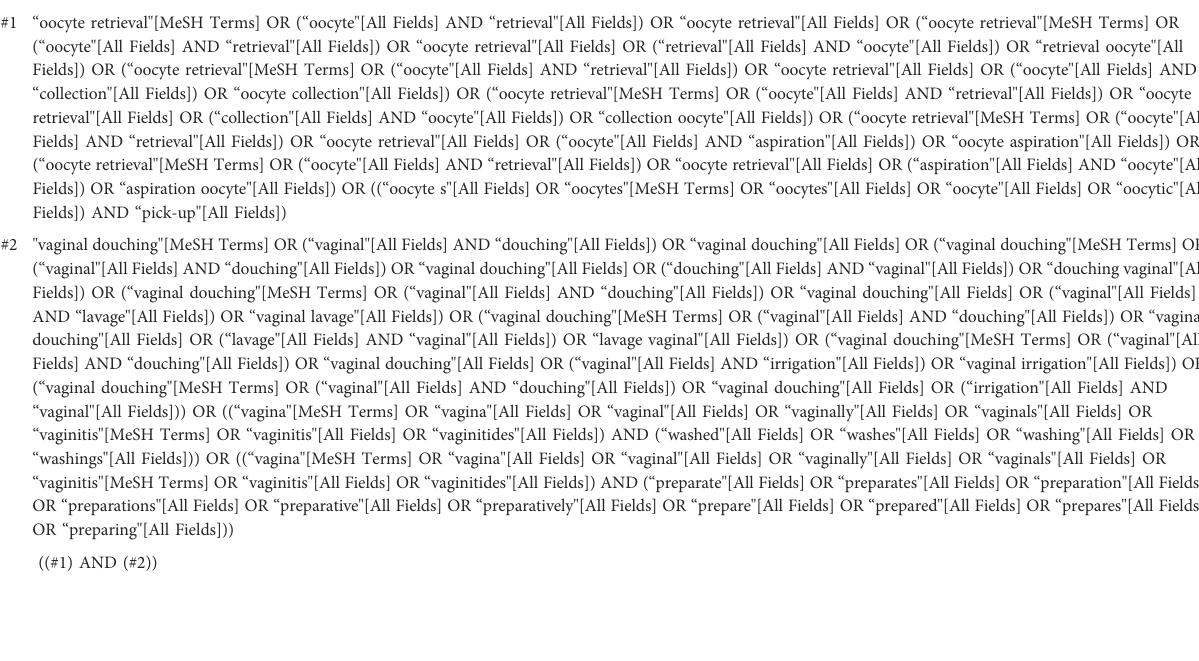
TABLE 1 Search strategy on